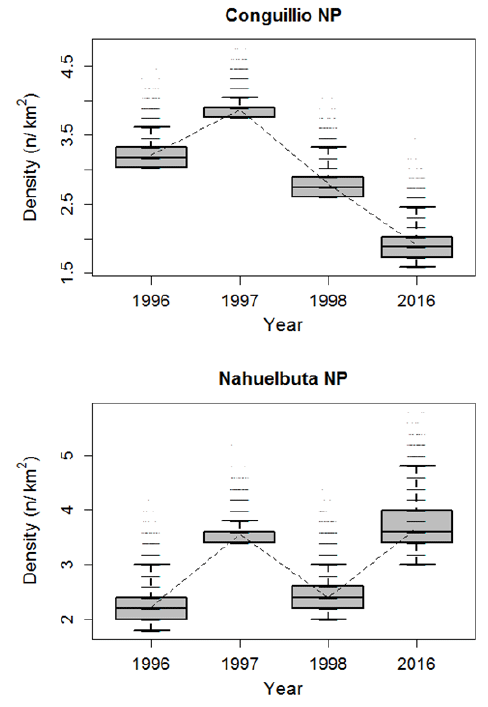
Fig. 3 . Boxplots for the yearly Bayesian estimates (Mean and 95% CI) of the Magellanic Woodpecker ( Campephilus magellanicus ) density (n/km²) at two different national parks in central-southern